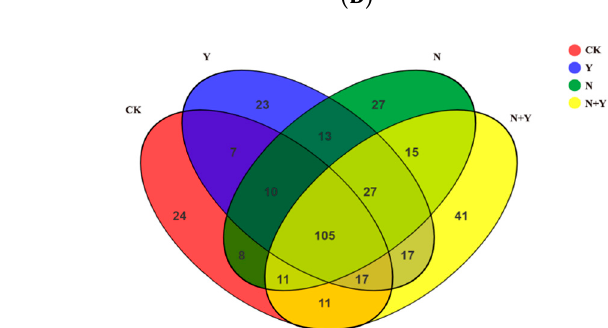
Table 6. The diversity and richness estimates for the different rhizosphere samples at 97% similarity.